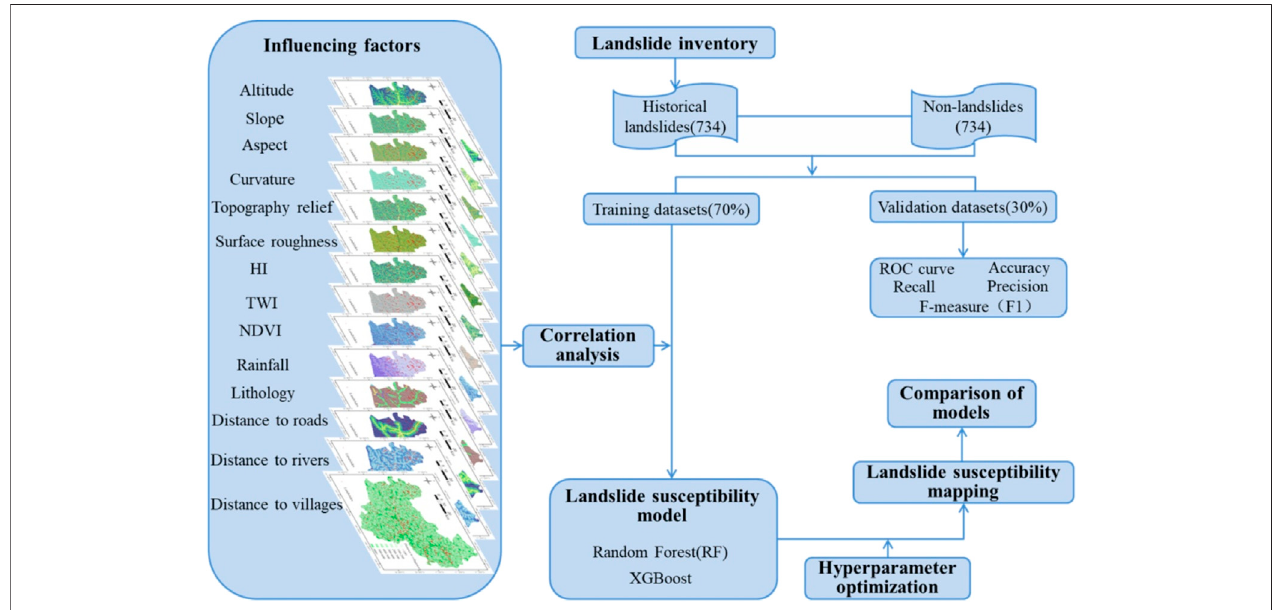
FIGURE 4 | Flowchart of the research methodology used to provide the landslide susceptibility map.